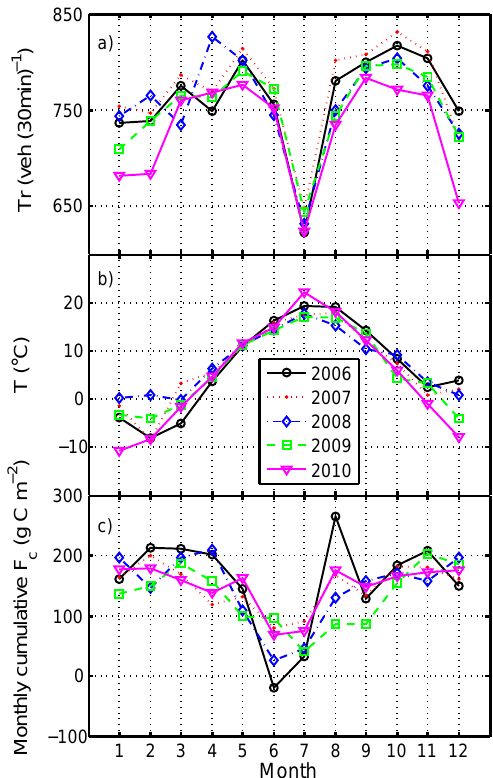
y-axis of Fig. 3 were wrong. The corrected figure is given below.